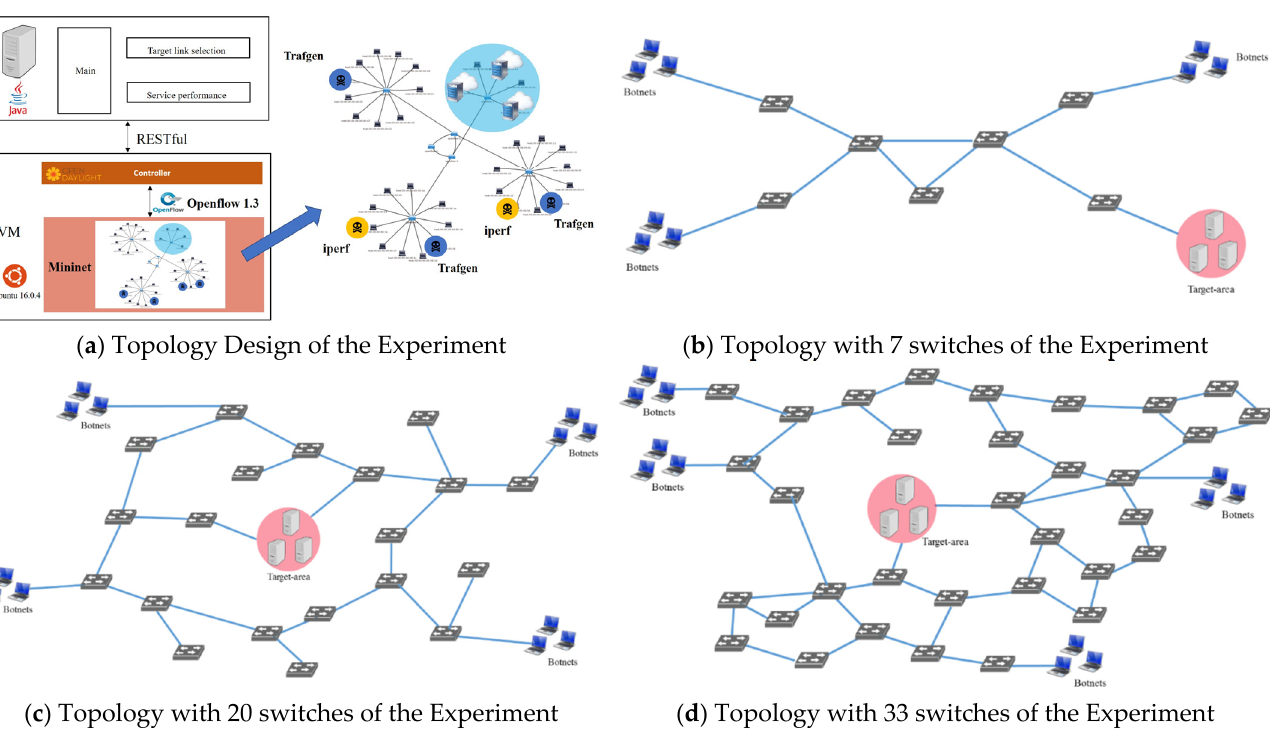
Figure 4. Experimental topology.